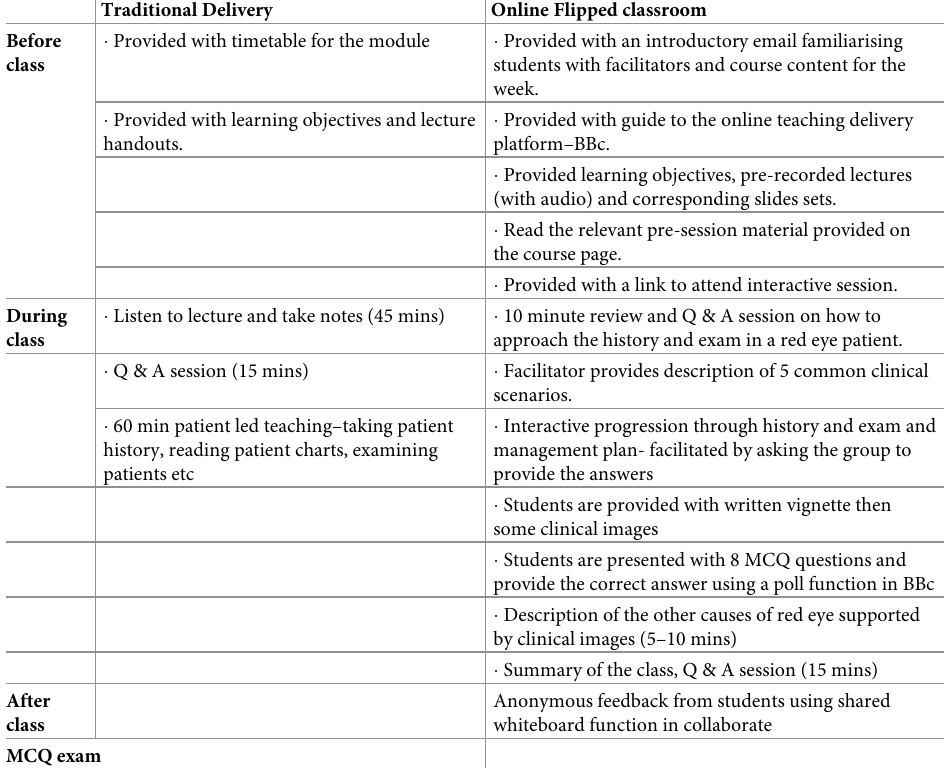
Table 1. Format of Red eye session comparing before, during and after class activities for the traditional delivery of the ophthalmology module and the online flipped classroom